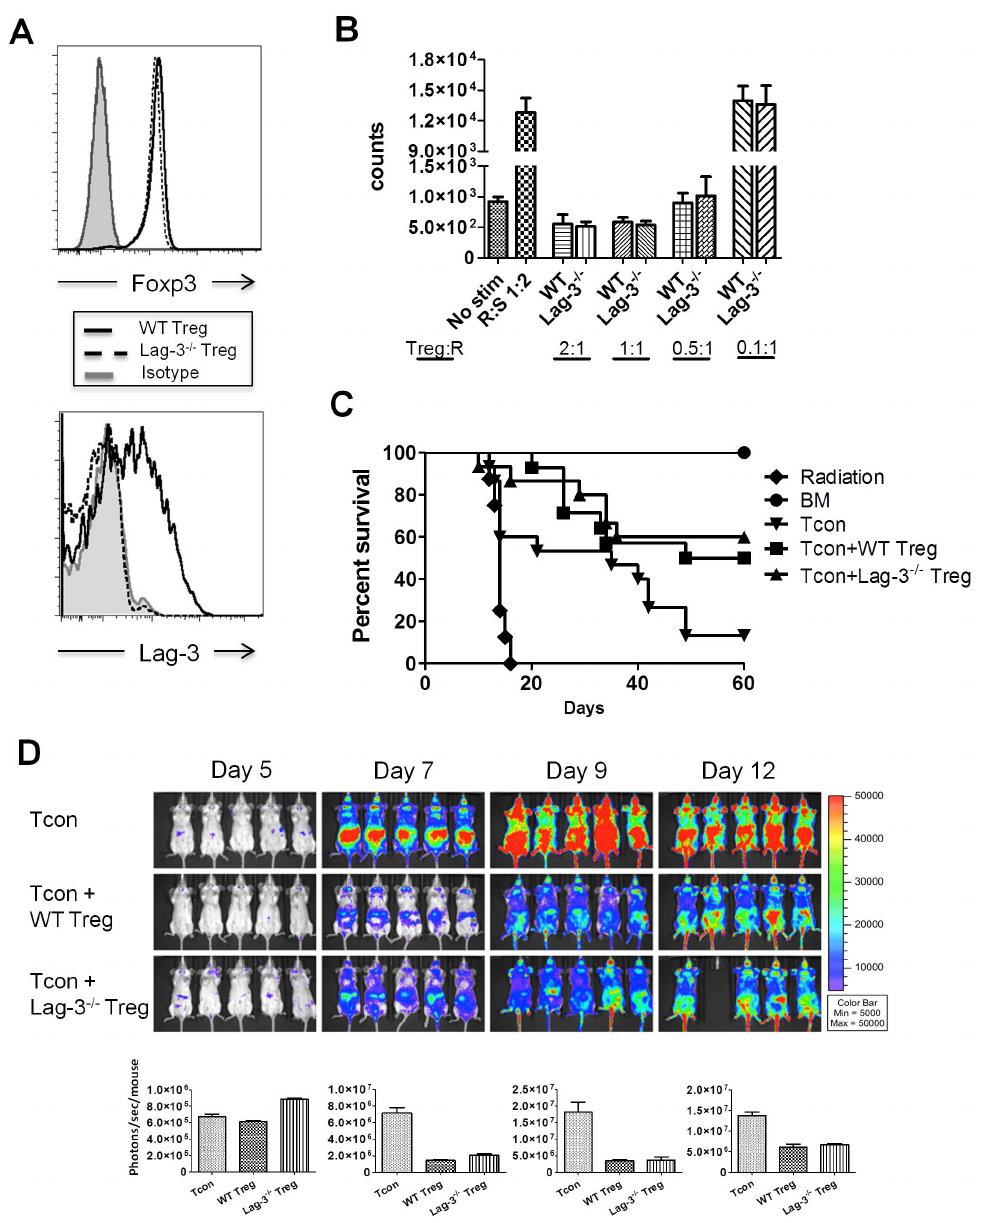
Figure 6. WT Treg and Lag-3 2 / 2 Treg show similar protection against GVHD. (A) Foxp3 staining (upper panel) and Lag-3 staining (lower panel) of CD4 + CD25 + T cells isolated from WT mice (black histogram) and Lag-3 2 / 2 mice (dashed histogram). For Lag-3 staining, lower panel, regulatory T cells were activated for 2 days with anti-CD3/anti-CD28 beads. Cells were gated on CD4 + Foxp3 + . The shaded histogram represents the isotype staining control. The histograms are representative of 2 independent experiments. (B) 3 H-thymidine incorporation of WT C57BL/6J responders to Balb/c stimulators in the presence of either WT Treg or Lag-3 2 / 2 Treg at different Treg to responder ratios, R: responders, S: stimulators. (C–D) Lethally irradiated Balb/c recipients were co-transplanted with 5 6 10 6 TCD-BM and 5 6 10 5 WT or Lag-3 2 / 2 Treg on day 0 followed by infusion of 1 6 10 6 luc + WT Tcon on day 2. (C) Percent survival of mice after transplantation. Graph contains data pooled from 3 independent experiments (n=15). P=0.034 for WT Treg + Tcon vs. Tcon and P=0.033 for Lag-3 2 / 2 Treg + Tcon vs. Tcon. (D) In vivo BLI images of mice receiving WT Tcon alone, WT Tcon + WT Treg and WT Tcon + Lag-3 2 / 2 Treg. Upper panels: BLI images taken at different time points after transplantation; lower panels: the corresponding quantitative analysis of the BLI signal. The BLI images are representative of 3 independent